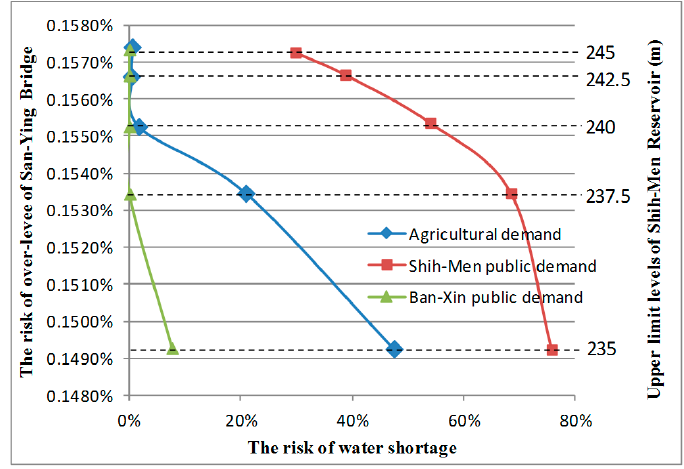
Figure 14. Risk relationship between shortages of each kind of demand node in a drought period and over-levee risk of San-Ying Bridge in a typhoon period for different upper limit levels of Shih-Men Reservoir.